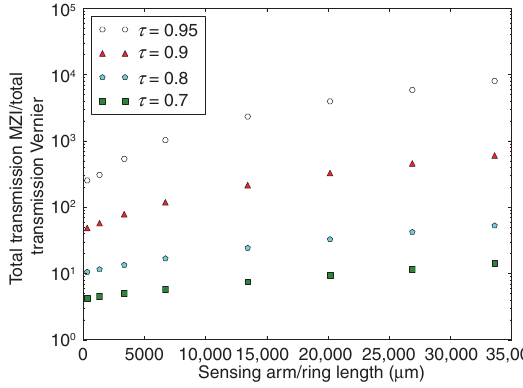
Figure 4: Ratio of total transmission within one FSR of the MZI to the Vernier. τ indicates the self-coupling coefficients of the Vernier